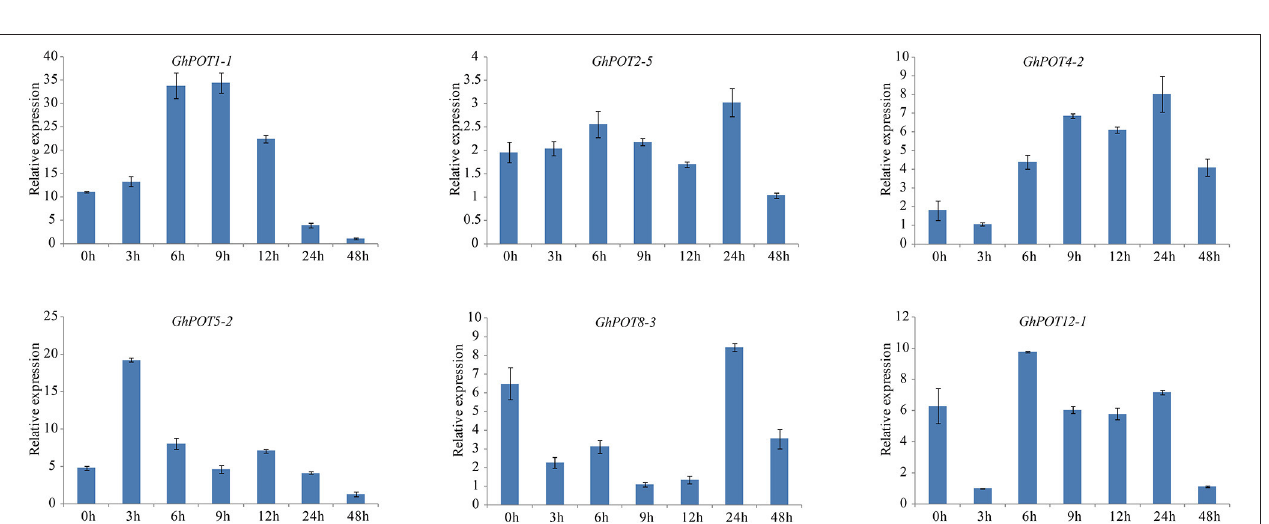
FIGURE 8 | Expressions of GhPOT genes in response to potassium deficiency stress (0.03mM KCl). The expressions of the GhPOT genes were determined by qRT-PCR using the total RNA isolated from TM-1 leaves at different time points (0, 3, 6, 9, 12, 24 and 48h) of dehydration stress. The error bars indicate the standard error (SE) of three biological replicates.